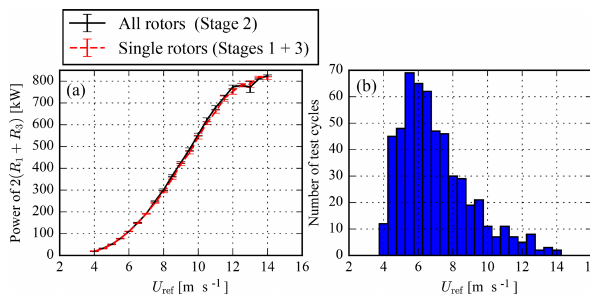
Figure 4. (a) Measured electric power of 2( R 1 + R 3 ) from the 4R- V29 wind turbine as a function of the free-stream velocity at a height of 44.27m for all rotors and single rotors in operation. Error bars represents the standard error of the mean power. (b) Number of test